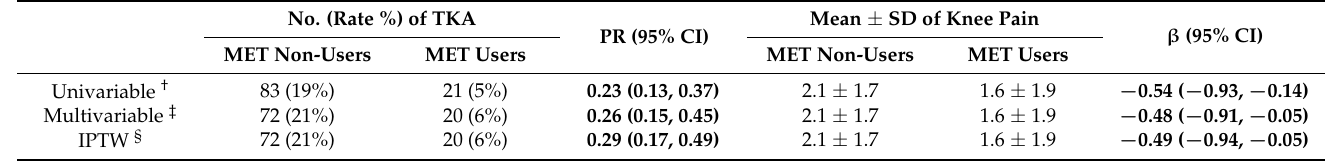
Table 2. Associations between metformin use and the risk of total knee arthroplasty and degree of knee